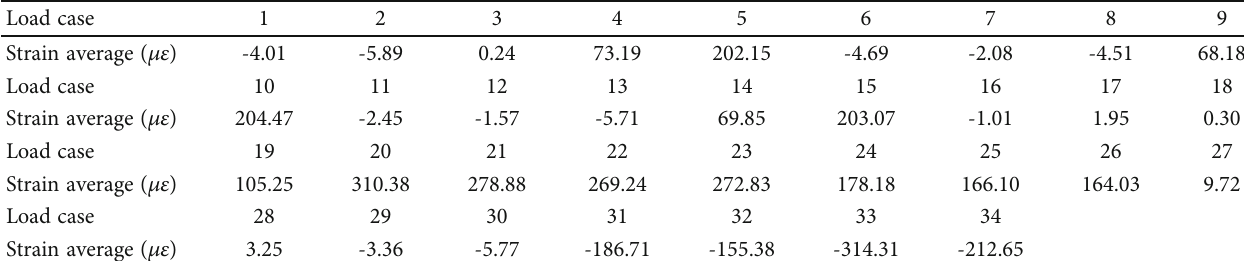
Table 2: Strain average of one strain point under 34 load cases.